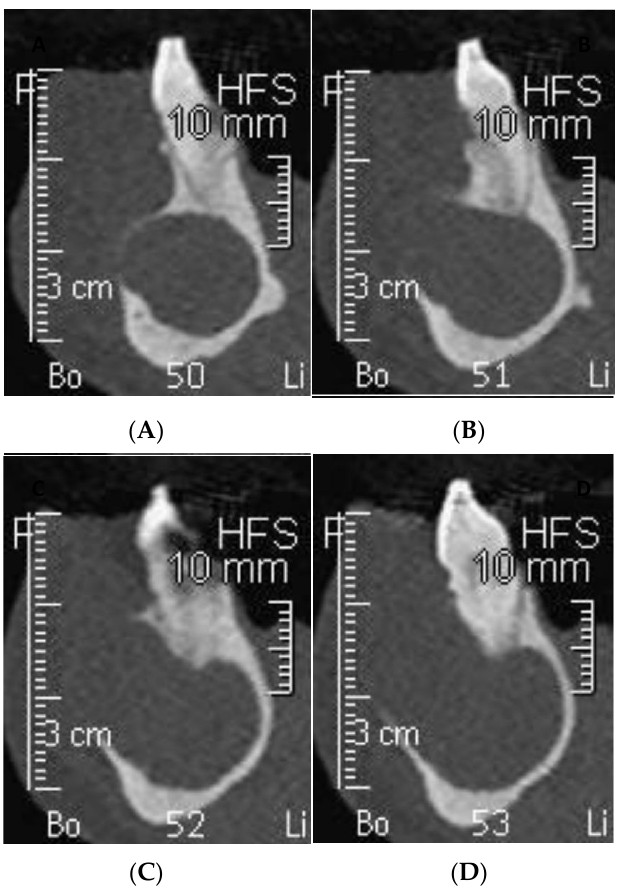
Figure 3. CBCT examination of sections between elements 3.3 and 3.4. ( A ) Distal aspect element 3.3 showing buccal osseous expansion. ( B ) Element 3.3, with evident buccal cortical bone erosion. ( C ) Increasing cortical opening due to cystic expansion. ( D ) Mesial of element 3.4 showing degree of buccal cortical bone elimination.